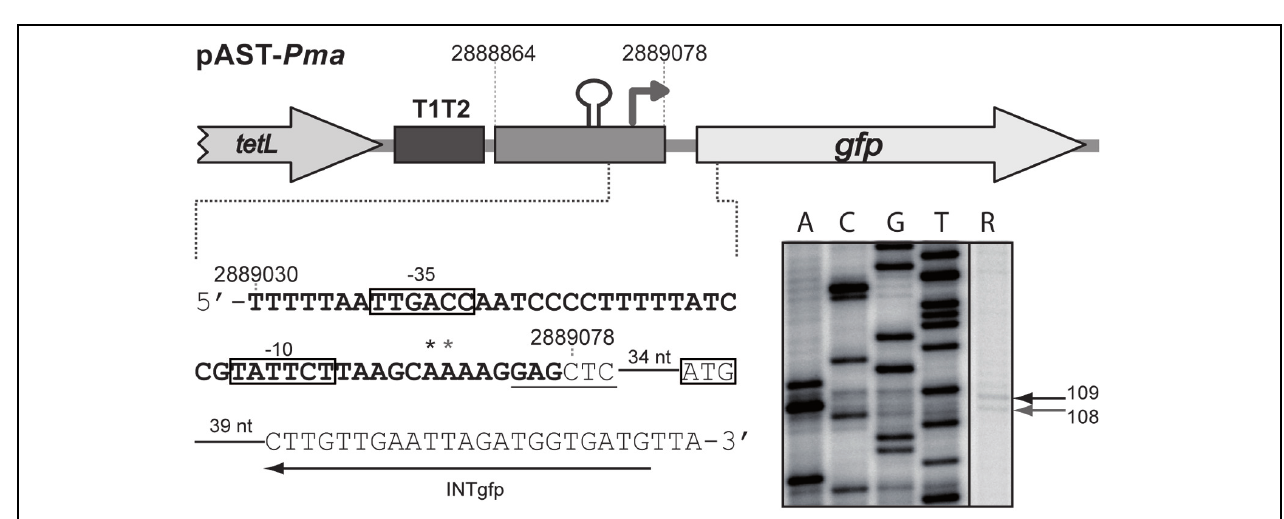
FIGURE 4 | Initiation of transcription at the Pma promoter. Primer extension reactions were carried out using total RNA from JH2-2 cells harboring plasmid pAST- Pma . The main sequence elements of the Pma promoter (–35 and –10 boxes), and the ATG initiation codon of the gfp gene are indicated. The Sac I site is underlined. The asterisks indicate the 3 (cid:3) -end of the cDNA products synthesized using the INTgfp primer. The sizes of the cDNA products (lane R) are indicated in nucleotides on the right of the gel. Dideoxy-mediated chain-termination sequencing reactions (M13mp18 DNA and primer –40 M13) were used as DNA size markers (lanes A, C, G,